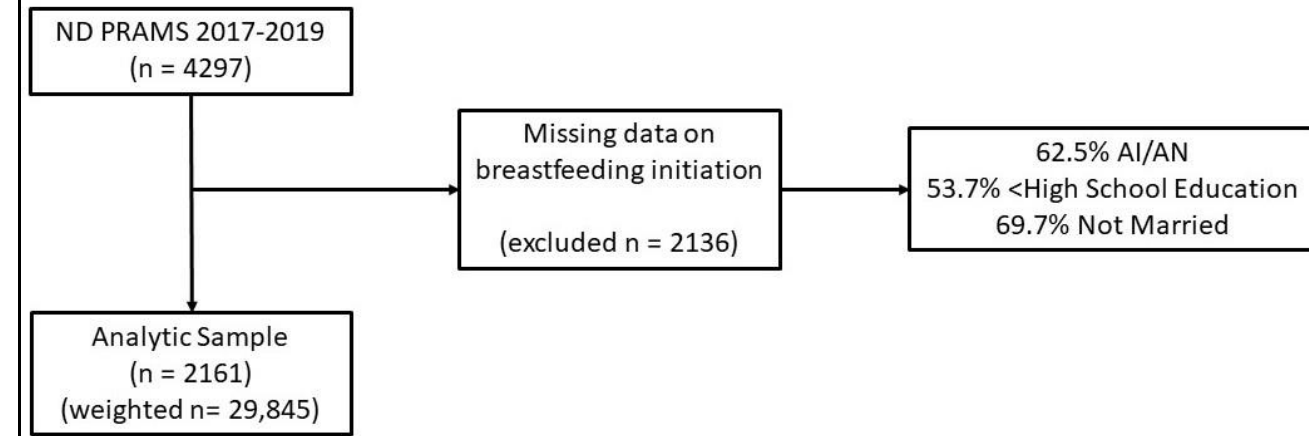
Figure 1. Study inclusion/exclusion flow chart.